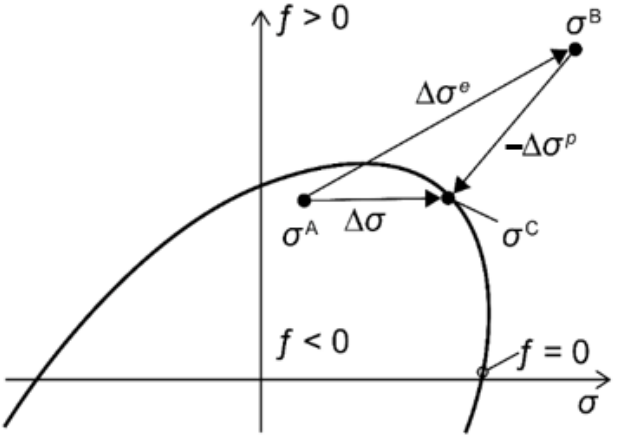
Figure 3. Principle of return mapping [17].